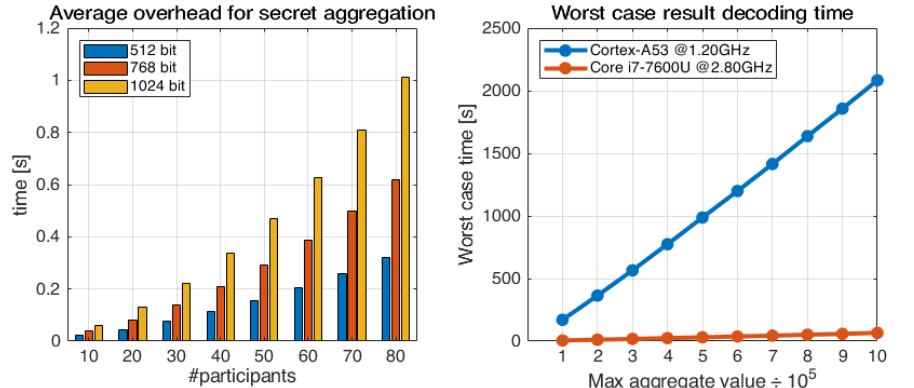
Figure 6. Testing of overhead and decoding times. The overhead increases for bigger (more secure) groups G and superlinearly with the number of participants, but remains manageable at realistic sizes. The decoding part is heavy on the Strato hardware, but it is not necessary to perform it at every market execution, and it can be executed on other